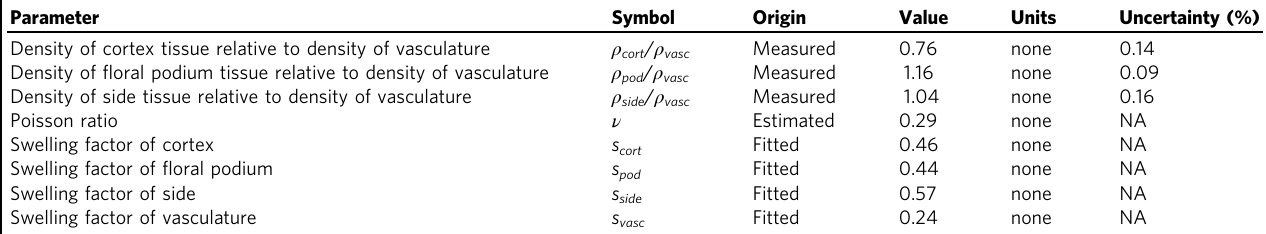
Table 2 List of measured, estimated, and fi tted parameters used to de fi ne material properties in the model. Parameter Density of cortex tissue relative to density of